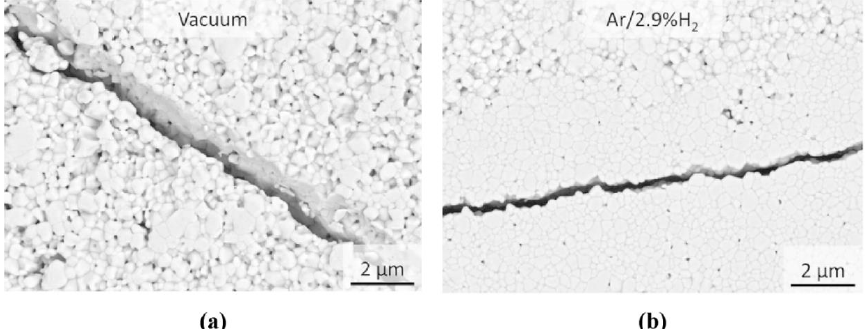
Figure 7. Microstructure of GDC10-HP samples after pressure-assisted FAST/SPS (a) in vacuum and (b) in Ar-2.9%H 2 . Materials 2020 , 13 , x